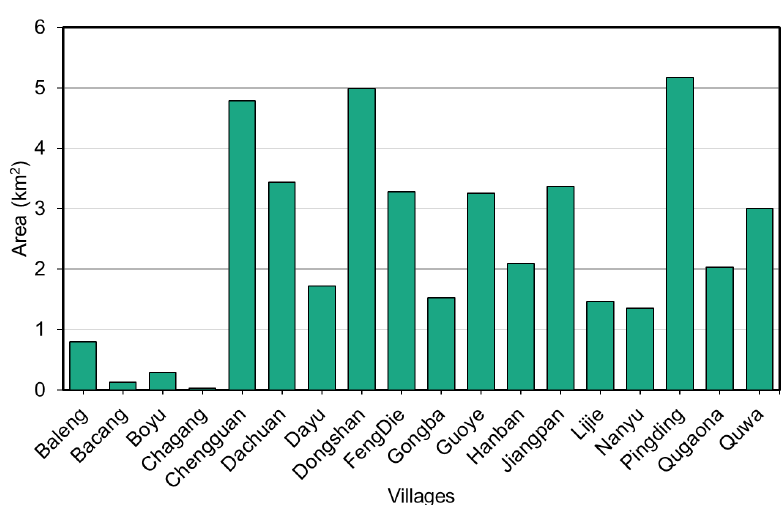
Figure 7. Percentage of landslide area in each village.